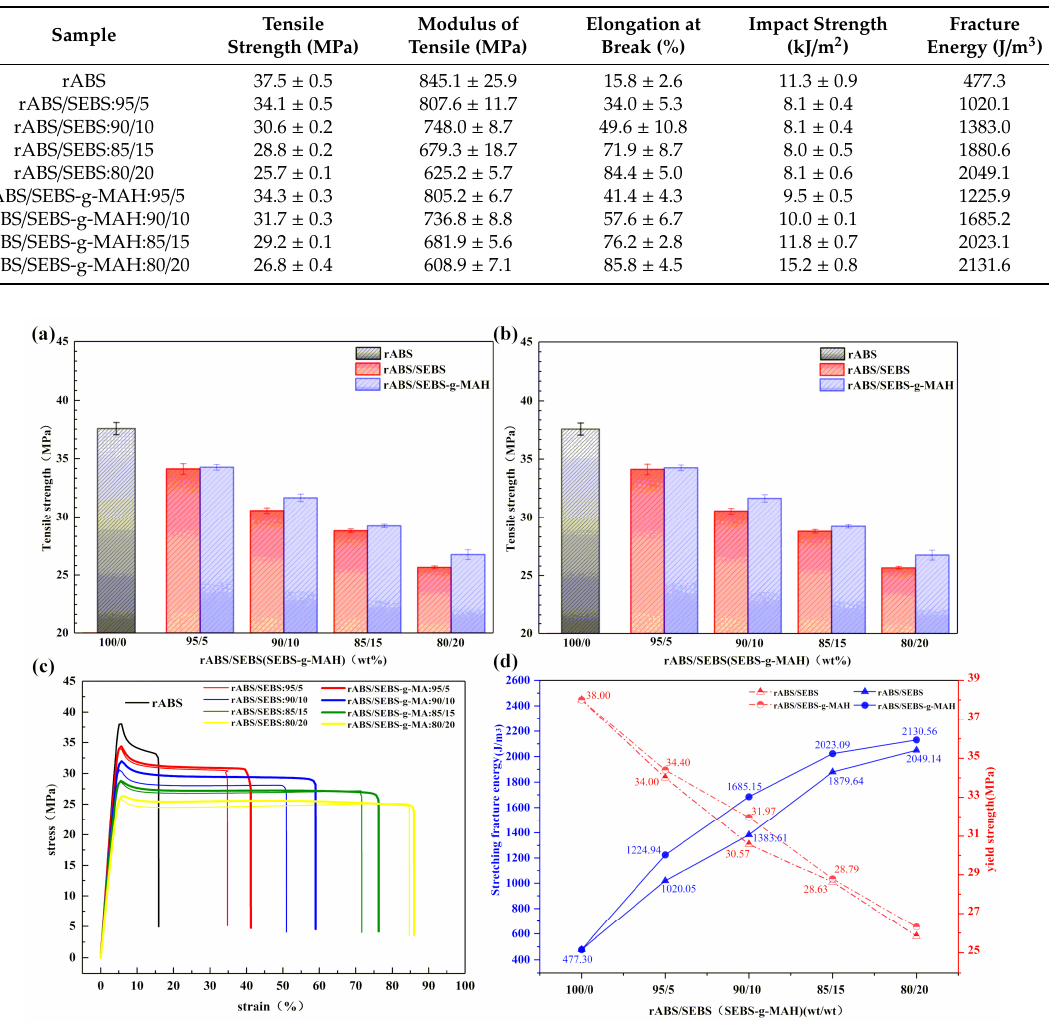
Figure 2. The tensile and impact properties of neat rABS, rABS / SEBS, rABS / SEBS-g-MAH blends: ( a ) impact strength; ( b ) tensile strength; ( c ) strain-stress curves; and, ( d ) fracture energy and yield strength.